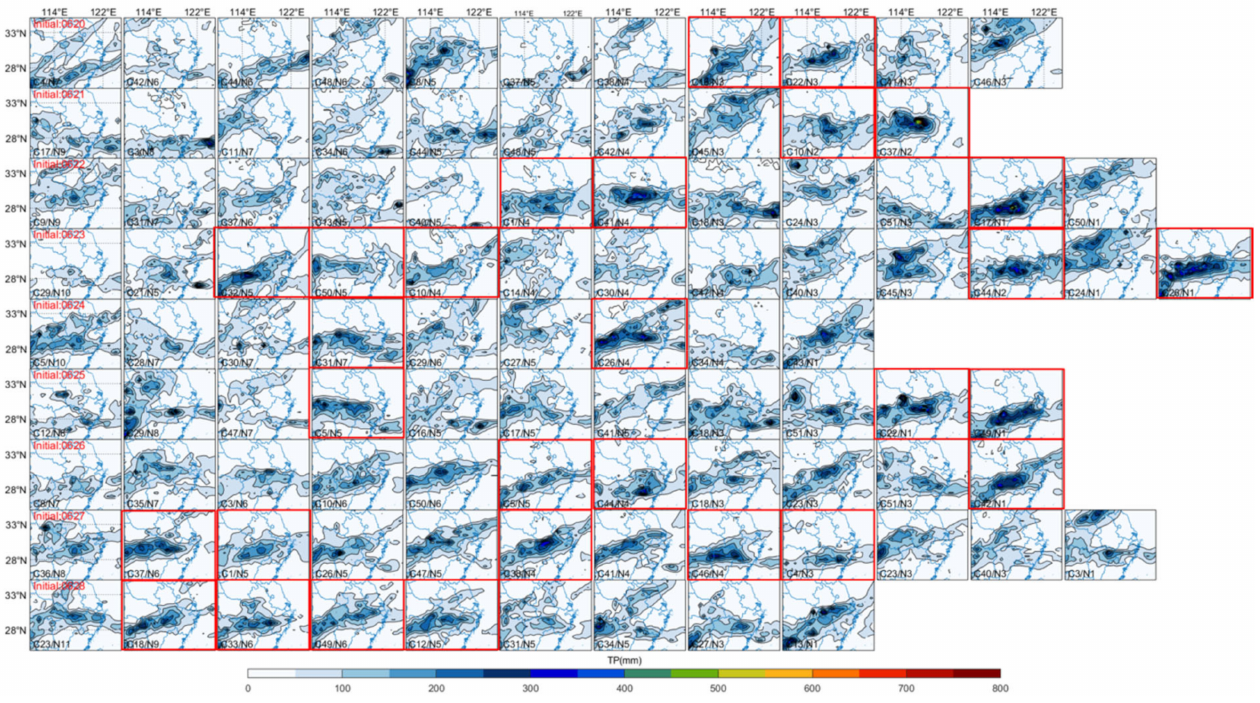
Figure 4. EOF_AP clustering results of the accumulated rainfall from 29 June to 2 July forecasted by the ECMWF ensemble model with a start time at 12:00 from 20 to 28 June (the clustering type close to observation is marked by the red box). Each row has the same start time, is arranged in descending order of the number of cluster members, and the string “Ci/Nj” at the bottom corresponds to the cluster center and the member number of each